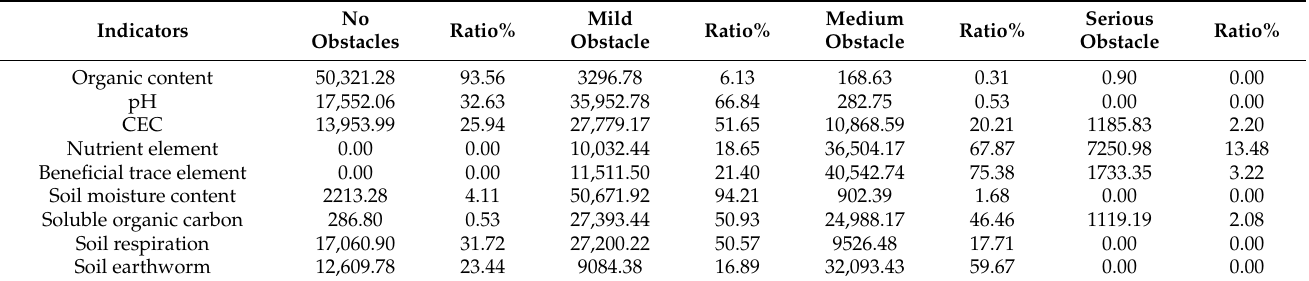
Table 5. Analysis of obstacle degree of SH evaluation indicators in Yixing City.